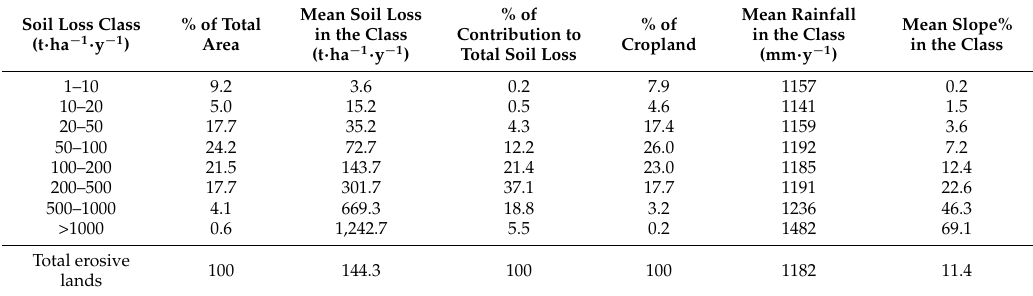
Table 2. The rates of potential erosion risk per class (of the entire erosive lands of 194,902.61 Km 2 ) corresponding to Figure 5a and focusing on the croplands, rainfall intensity, and slope gradient.